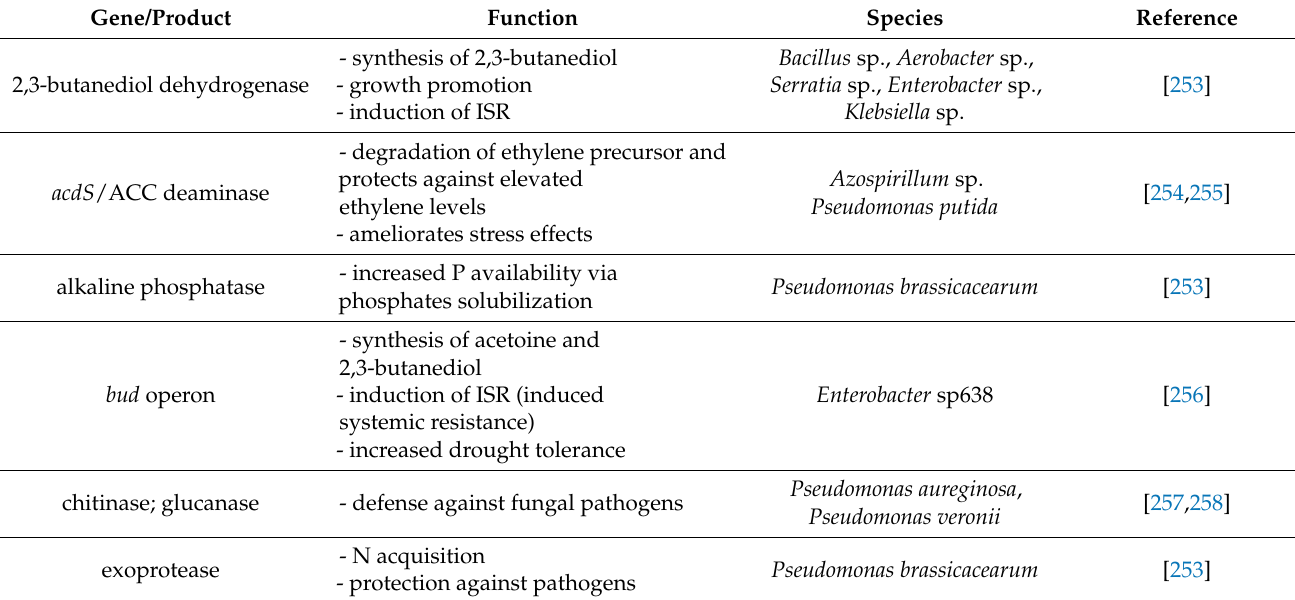
Table 3. Examples of mechanisms of plant growth promotion by